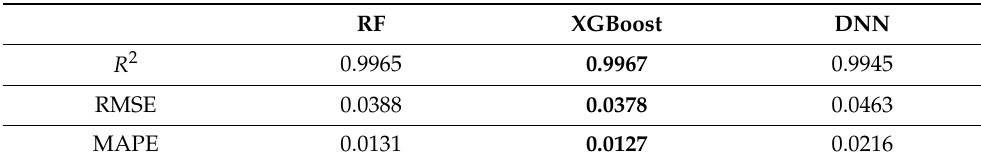
Table 5. Optimal statistical measures for different ML-based regression models trained, validated and tested on SMOTE-set .